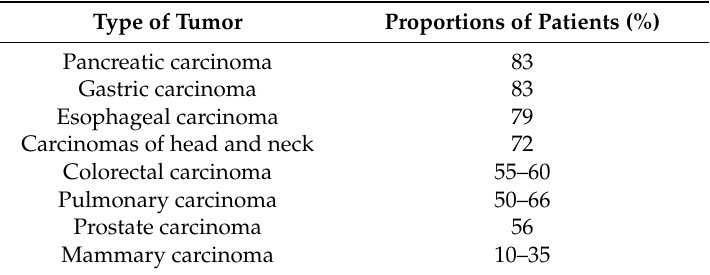
Table 1. Incidence of malnutrition in dependence of the tumor